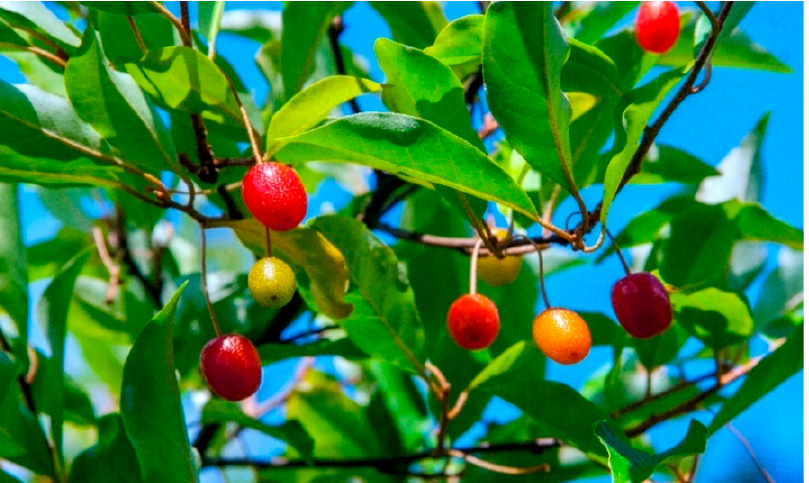
Figure 1. Elaeagnus multiflora Thunb. with fruit.